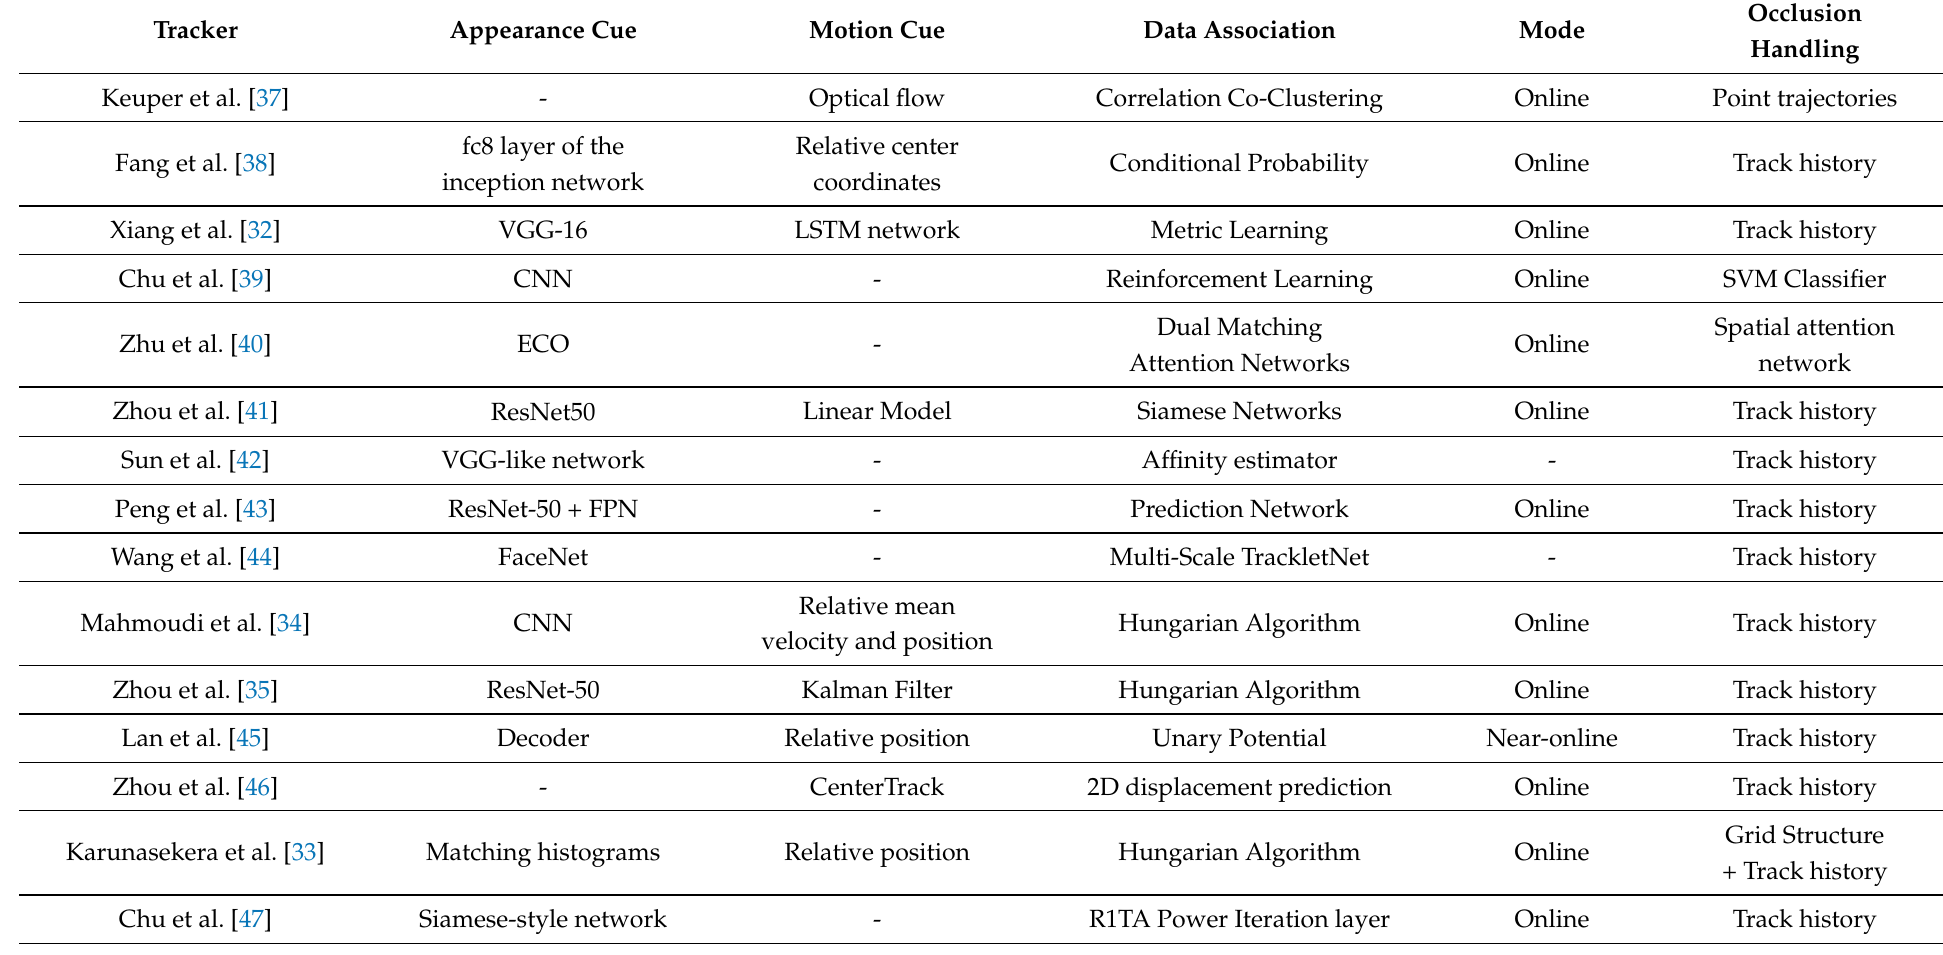
Table 2. Summary of the components used in MOT